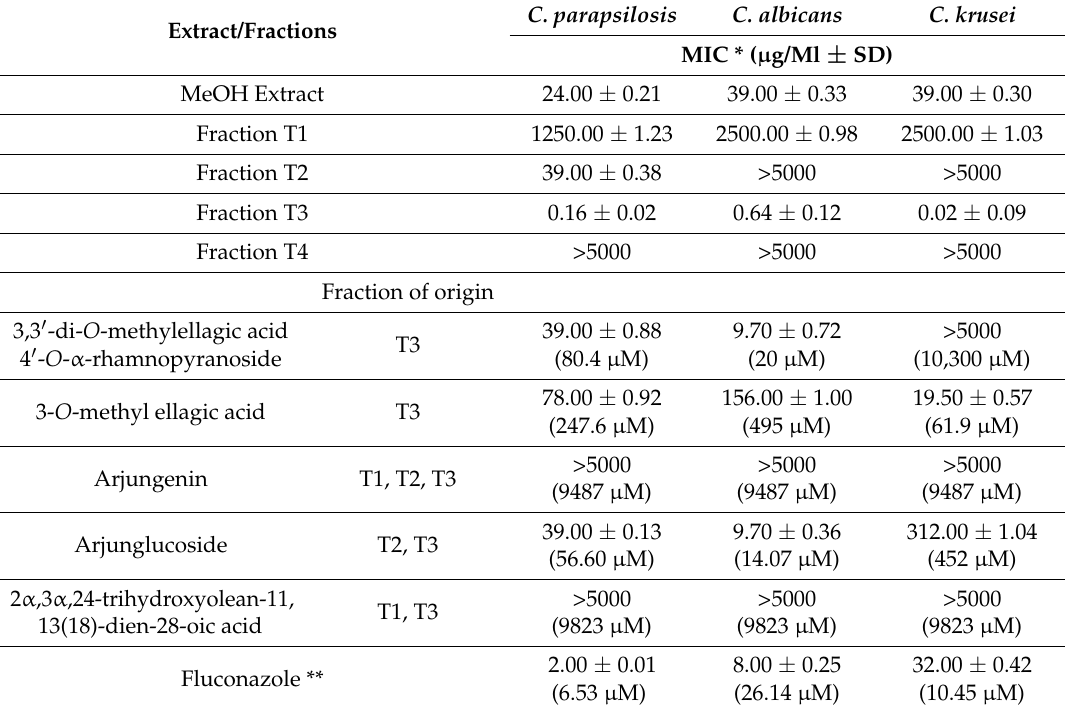
Table 1. Anti-yeast activity of Terminalia mantaly extract and isolates.